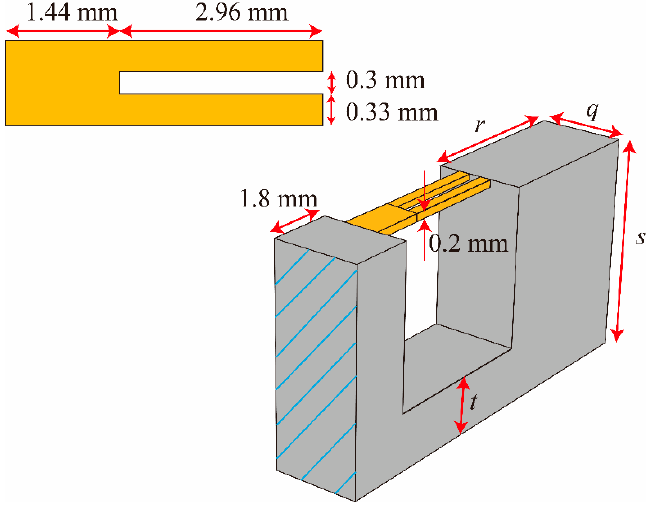
Figure 6. 3D topology of the final design of the DETF-based resonant accelerator.